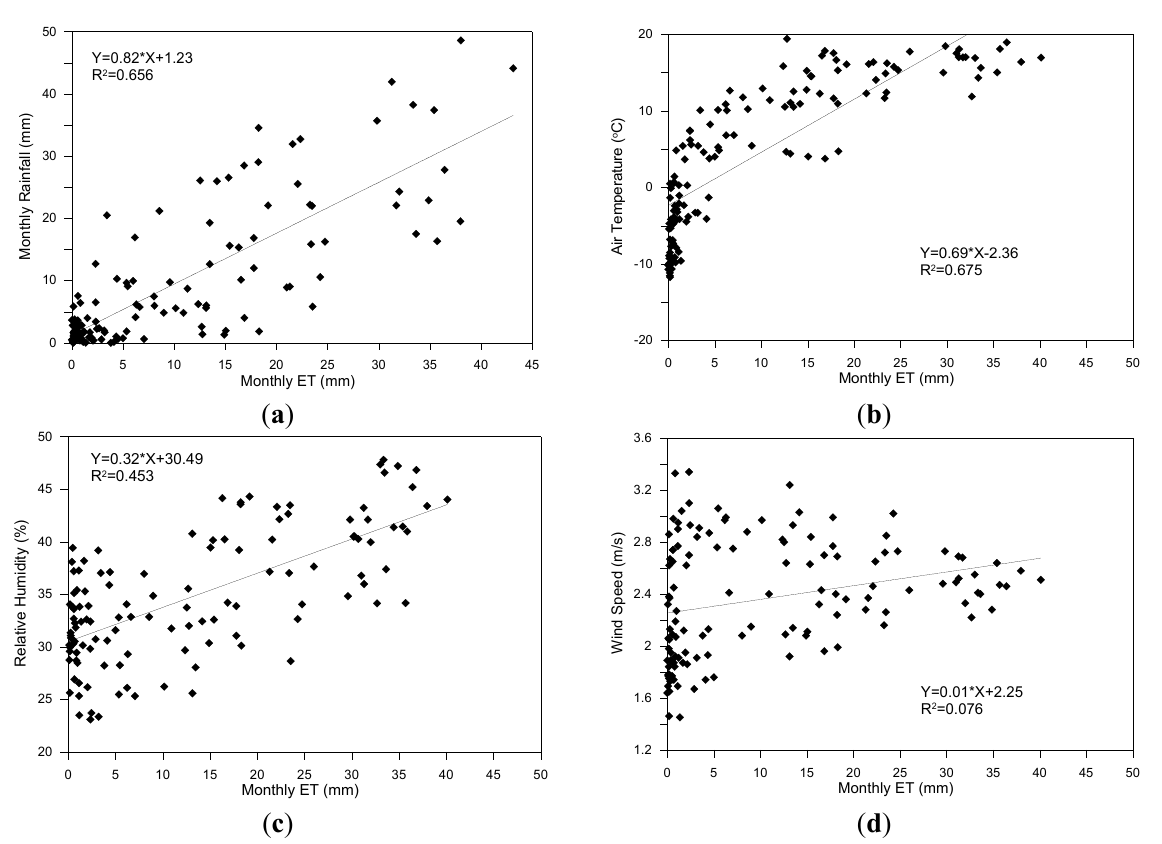
Figure 7. Correlation between ( a ) precipitation, ( b ) air temperature, relative humidity, ( c ) wind speed and ( d ) SEBS ET a